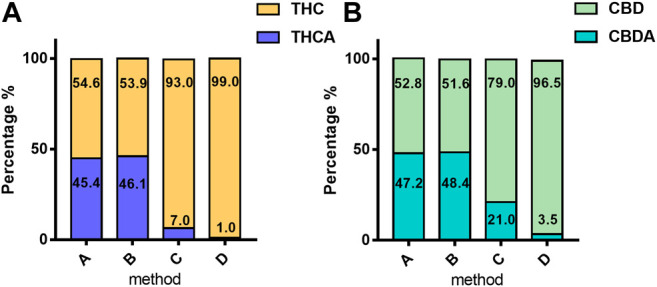
Mean percentage of acidic and neutral form of phytocannabinoids in 4,774 samples according to the extraction method: (A) THC and THCA; (B) CBD and CBDA. The values are expressed as mean normalized to 100: % acidic form = [Meanacid/(Meanacid + Meanneutral)] × [100/(Meanacid + Meanneutral)]; % neutral form = [Meanneutral/(Meanacid + Meanneutral)] × [100/(Meanacid + Meanneutral)]. For details on preparation methods, see the following references: Method A (Romano and Hazekamp, 2013), Method B (Citti et al., 2016), Method C (Società Italiana Farmacisti Preparatori (SIFAP), 2016; Casiraghi et al., 2018), and (Method D (Calvi et al., 2018).